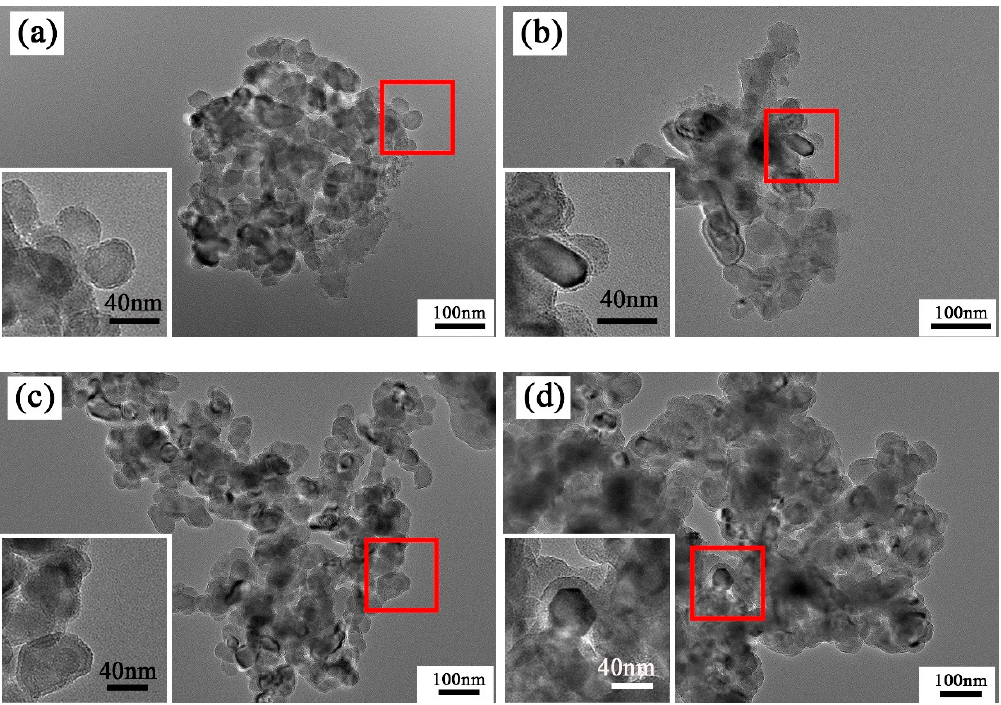
Figure 4. TEM micrographs in the presence of different tetraethoxysilane (TEOS) amounts. ( a ) 1 mL ( b ) 2 mL ( c ) 3 mL ( d ) 4 mL of TEOS.